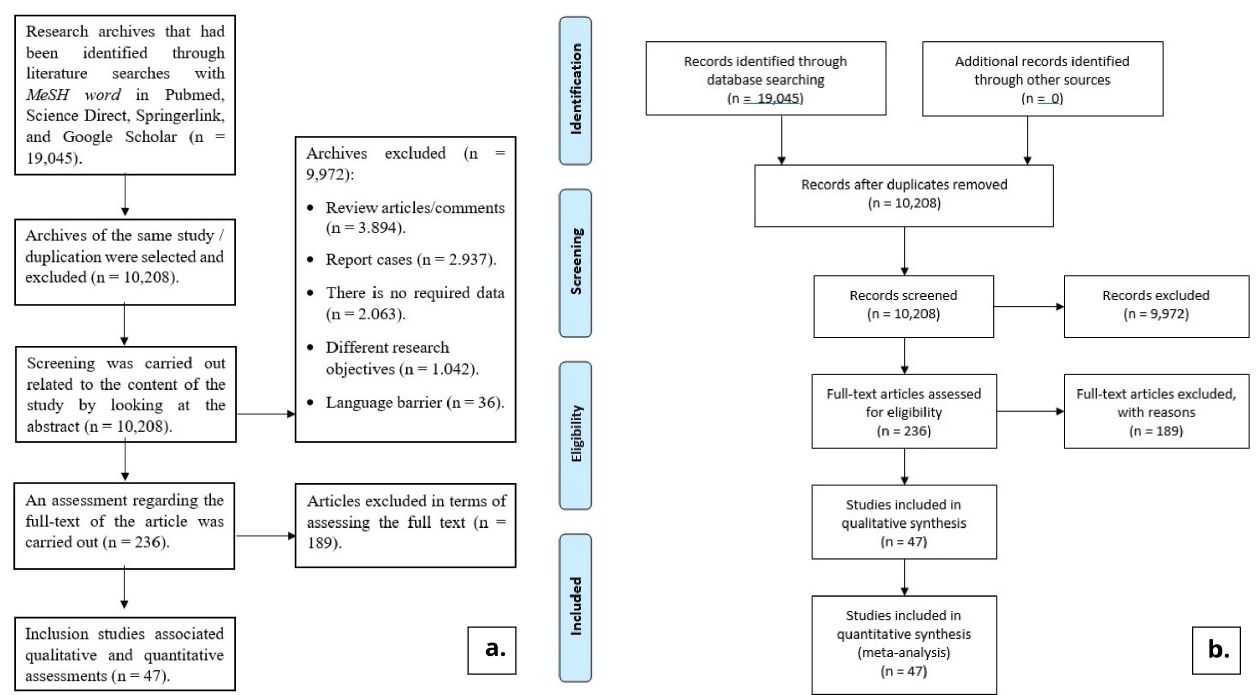
Figure 1. Flowchart ( a . detailed literature tracing and selection flowchart, b . PRISMA